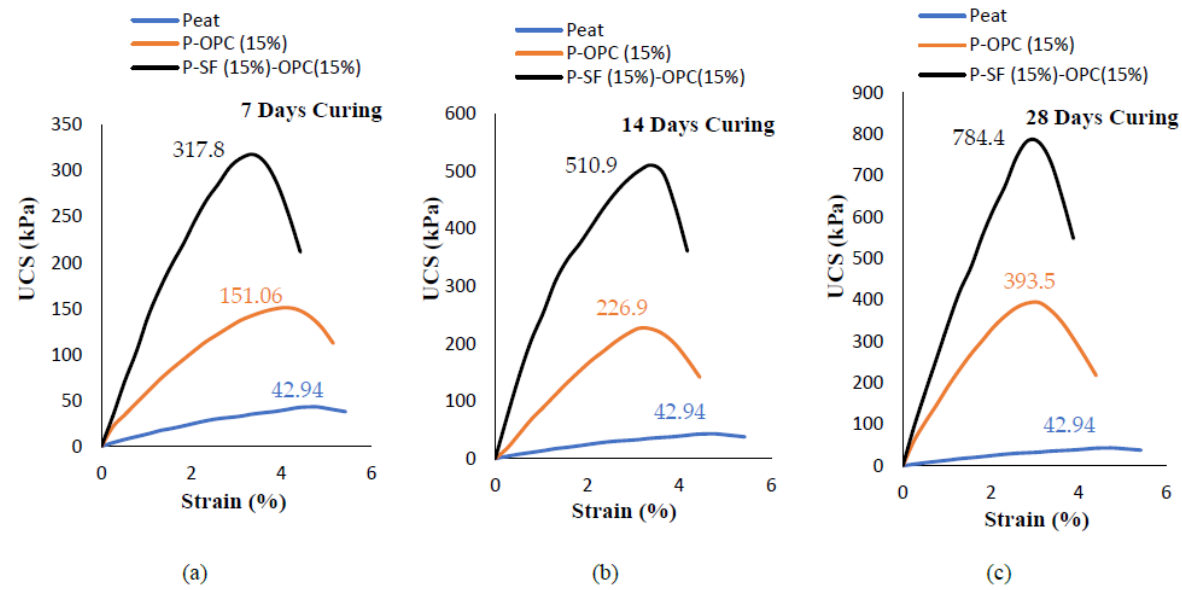
Figure 5. The unconfined compression strength of untreated peat, 15% OPC-stabilized peat, and 15% SF- and 15% OPC- stabilized peat under varying curing periods: ( a ) 7 days, ( b ) 14 days, and ( c ) 28 days.